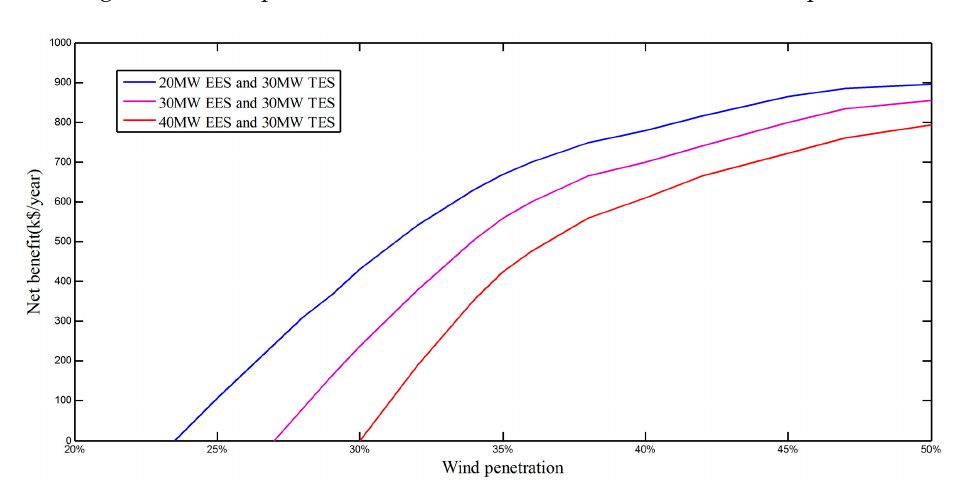
Figure 13. Annual net benefits at different wind penetration levels. Table 2. Parameters of hydrogen storage and thermal storage for investment.